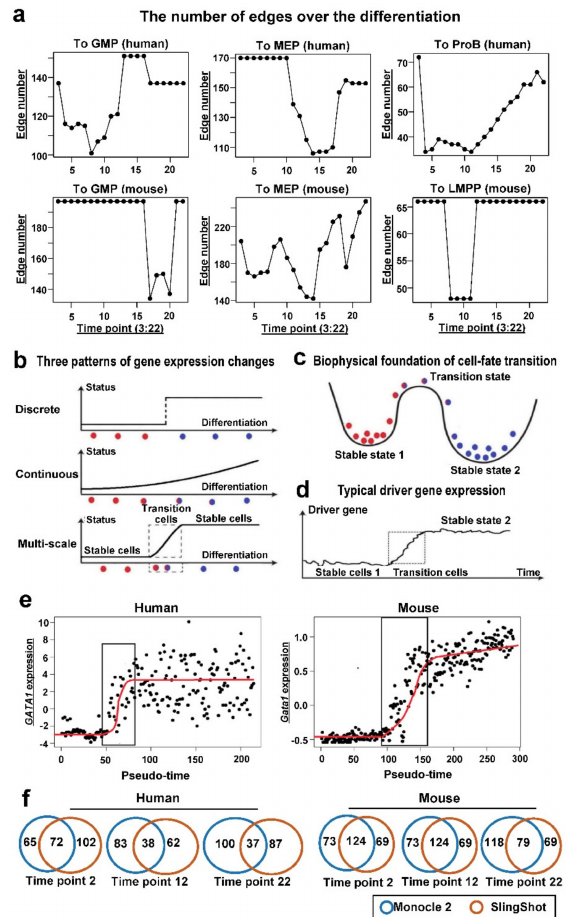
Figure 3. ( a ) The number of edges over the differentiation of three branches. All showed U shapes. “To ProB” in human corresponds to “To LMPP” in mouse, both are for lymphoid direction. ( b ) Three patterns of gene expression changes. ( c ) Biophysical foundation of cell-fate transitions. Stable states corresponded to basins while the transition states were at the saddle points. A transition state (with blue and red colors) owned both characteristics of two stable states, and drifted towards to the second one over time. ( d ) Expression of typical driver genes fluctuated within the stable cells. ( e ) Sigmoid shapes of GATA1 (human) and Gata1 (mouse) expression. ( f ) Venn diagrams of overlaps of interactions between Monocle 2- and SlingShot-based